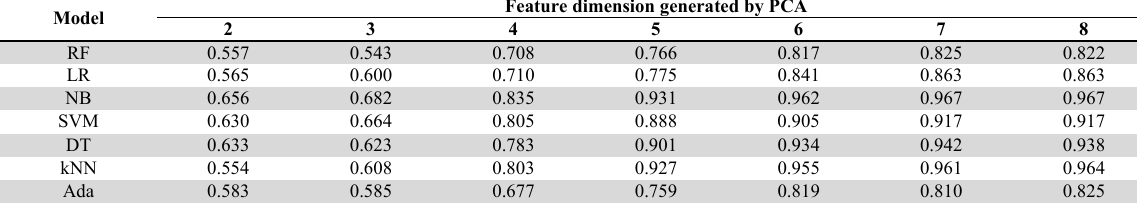
Results of AUC evaluation measure against different feature dimensions generated by PCA Model